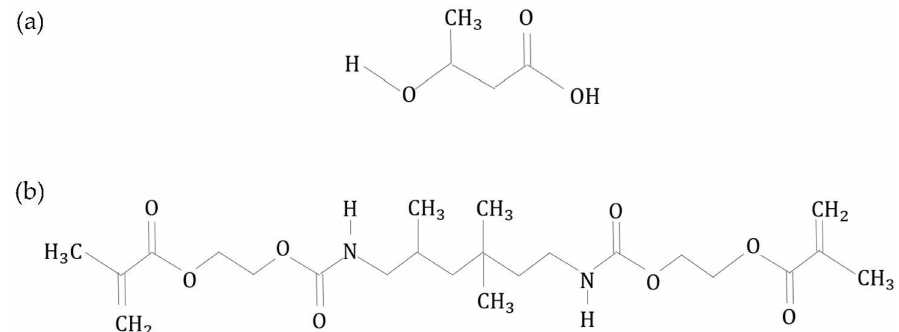
Figure 7. The molecular structure: ( a ) PHB and ( b ) UDMA.